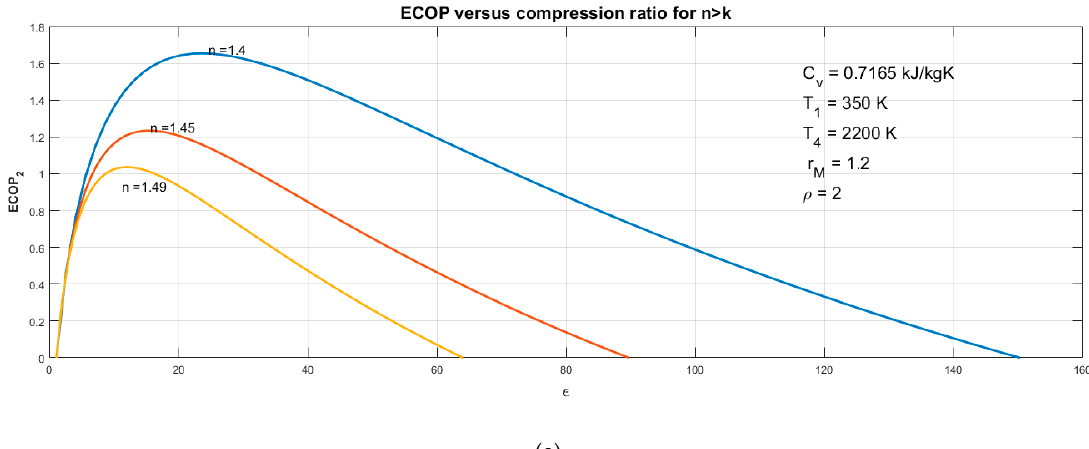
Figure 8. Impact of n ( n > k ) on E un – P 2 ( a ) and E un – 𝜂 2 ( b ).